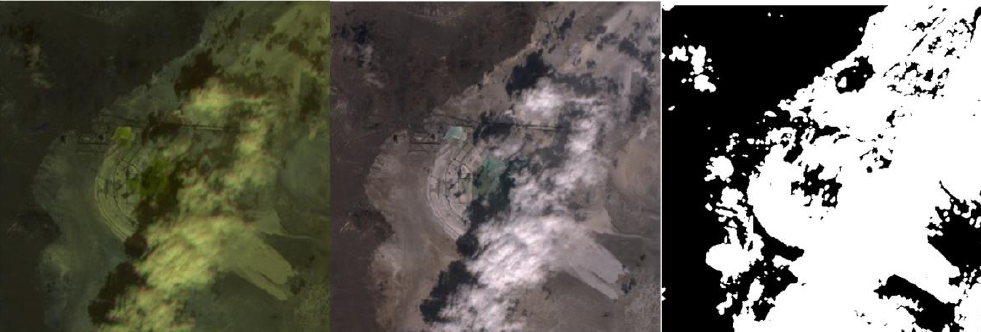
Figure 11. Bonneville clouds and shadows; radiance image, RGB image, cloud